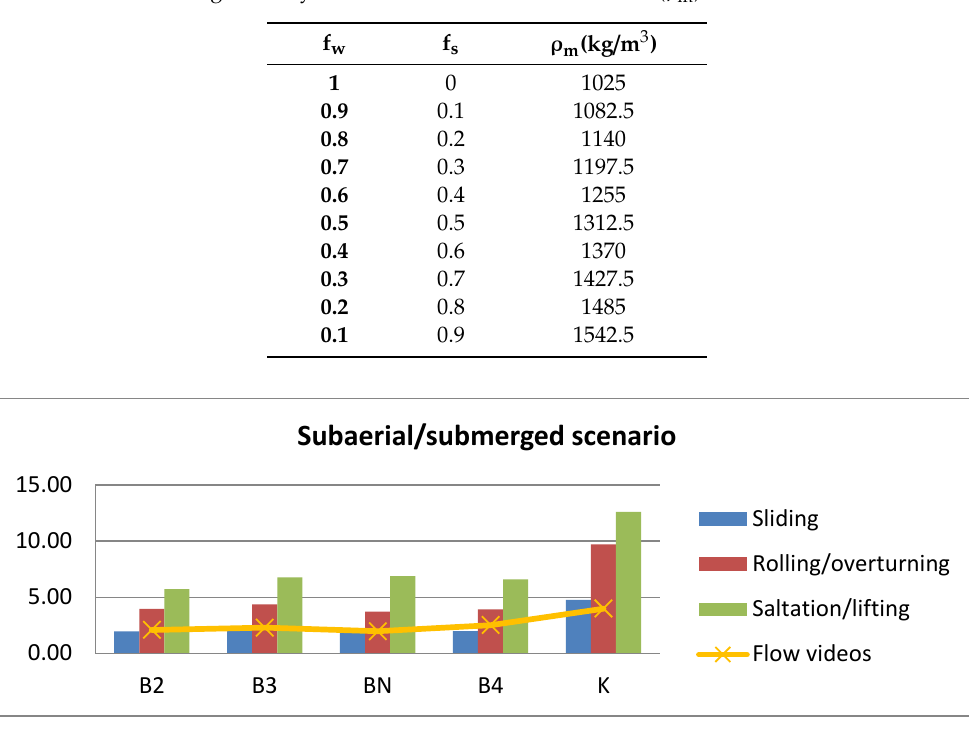
Figure 15. Flow needed to move the boulders, evaluated using Nandasena et al. [32] relationships, included correction for values of water flow density, compared with flow derived by video analysis.